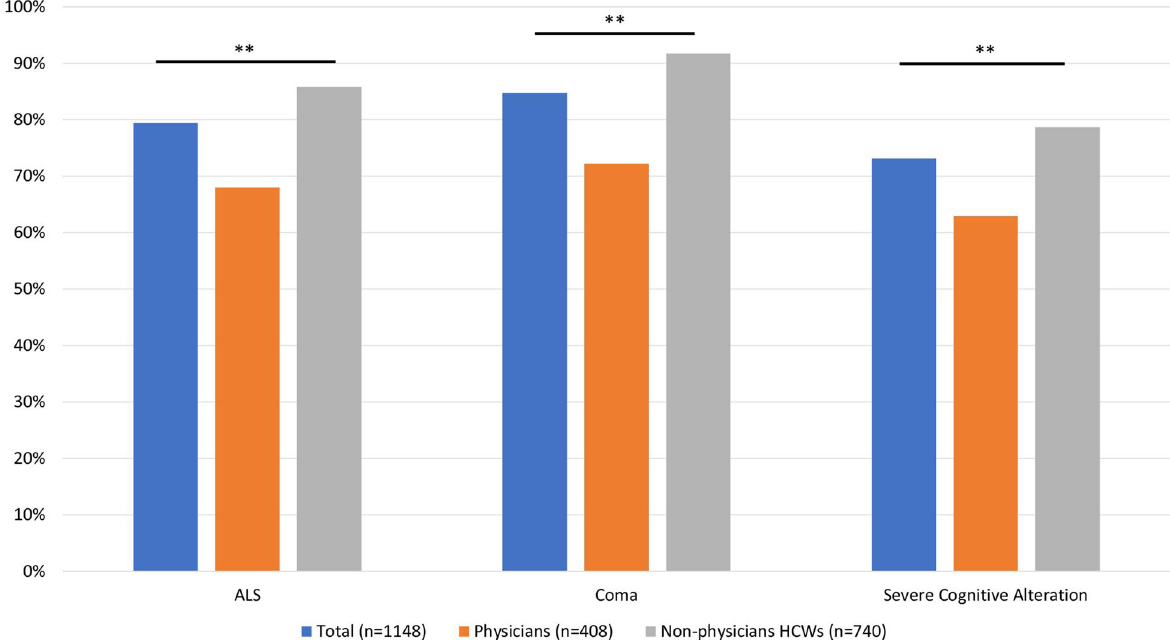
Fig. 2 Rates of favorable responses for legislation that would legalize active medical assistance in dying according to 3 case vignettes. ALS Amyotrophic lateral